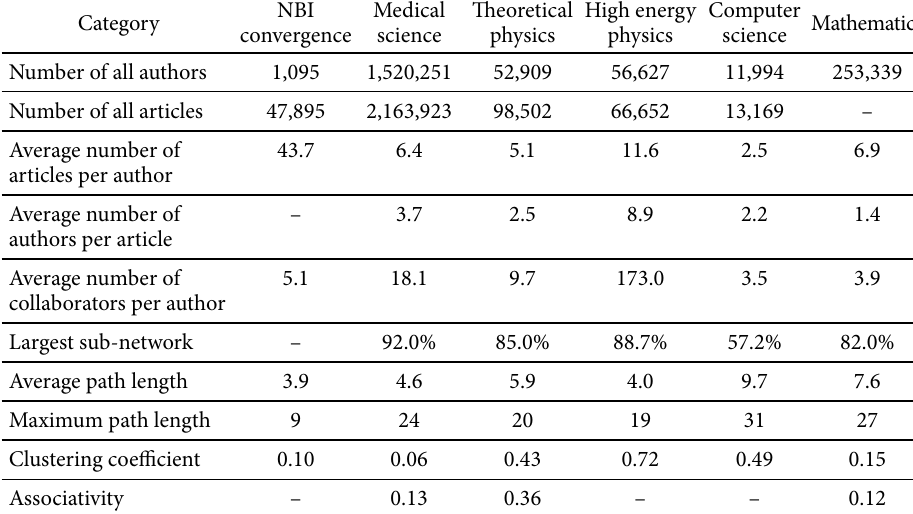
Table 2. Comparison of our results with previous studies